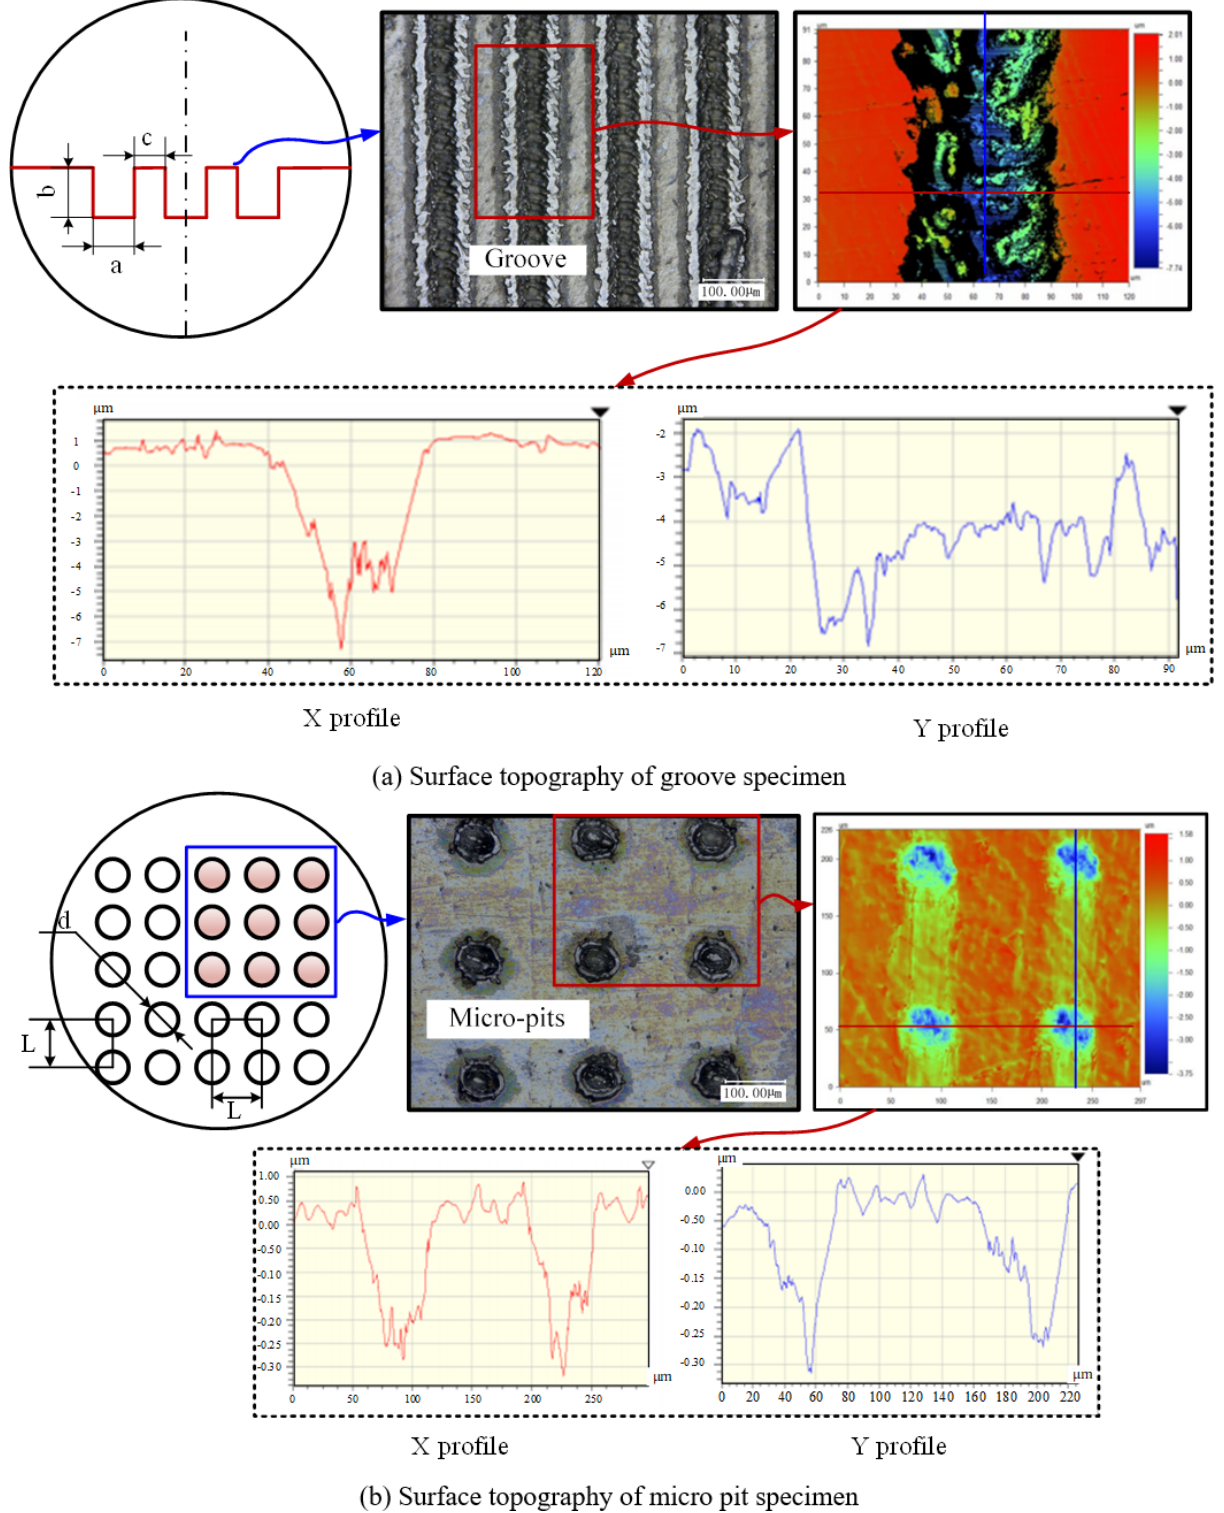
Figure 14. Surface topography of specimen. (a) Surface topography of groove specimen. (b) Surface topography of micro pit